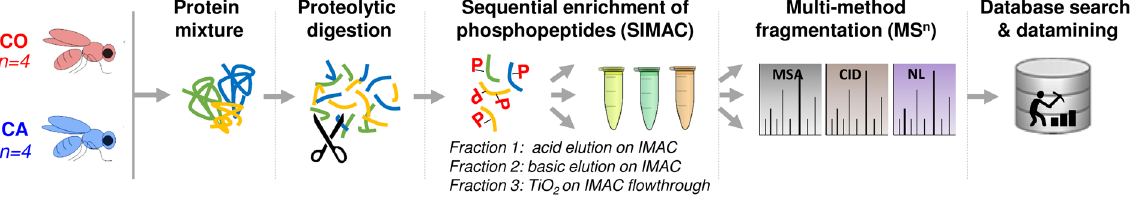
Figure 1. Schematic illustration of the s trategy used for comparative phosphoproteomic analysis of D. melanogaster adults that were cold acclimated (CA) versus control (CO). For each replicate ( n = 4), lysate was collected from 20 virgin females and 4 mg of proteins were subjected to proteolytic digestion. Tryptic peptides were desalted and enriched for phosphopeptides using three sequential steps: IMAC with an acidic elution (fraction 1), IMAC with basic elution (fraction 2), and TiO 2 on the IMAC flow through (fraction 3). Three different MS methods were then used for each elution fraction: a classical Collision-Induced Dissociation (CID), a Neutral Loss (NL) and a Multi-Stage Activation